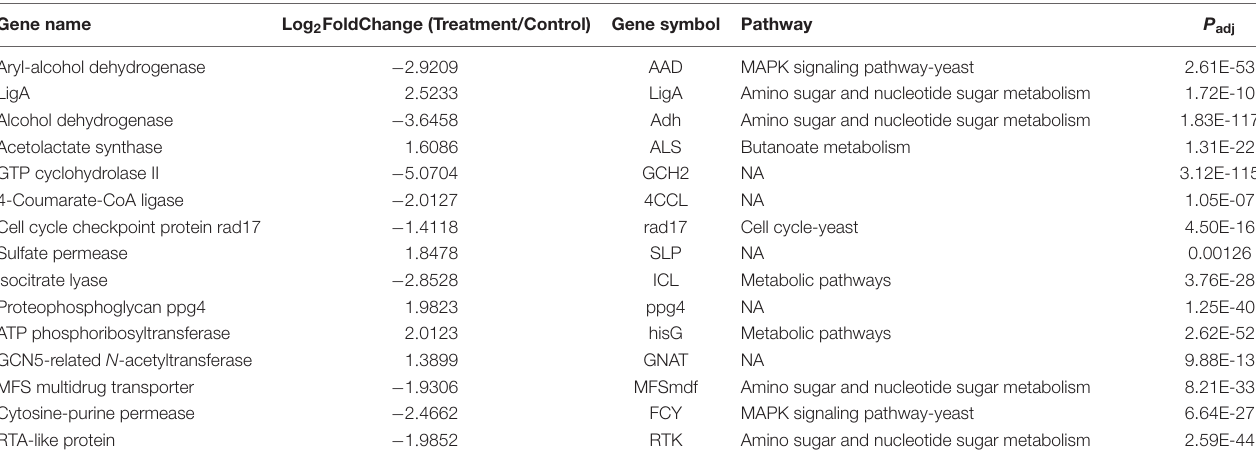
TABLE 1 | List of randomly selected 15 differentially expressed genes